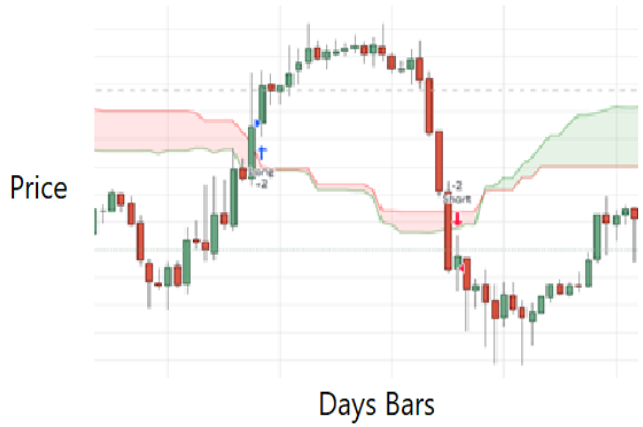
Figure 2. Ichimoku cloud long and short signaling. Chaikin Money Flow (CMF) developed by Marc Chaikin is a volume-weighted aver- age of accumulation and distribution over a specified period. The contribution of CMF to our trading system is its ability to identify market direction by integrating trade volumes with price movements. Above zero CMF is serves as an uptrend signal while below zero scores is a downtrend signal. MACD is a trend momentum indicator that measures the difference between two Exponential Moving Averages (EMA) (the exponential moving average is a moving average that places a greater weight on the most recent data than older data) of a financial asset’s price. When the MACD crosses above its signal line (the signal line is a nine-day EMA of the MACD) , an uptrend is predicted and when the MACD crosses below its signal line a downtrend is predicted. The long entry conditions are described in Equations (4)–(7) and the short entry conditions are described in Equa- tions (8–(11). Conditions 4 and 5 for long trades and 8 and 9 for short trades are derived from IC calculations, while Conditions 6 and 10 (long and short) are derived from the CMF indicator calculations, and 7 and 11 (long and short) are derived from the MACD formula.